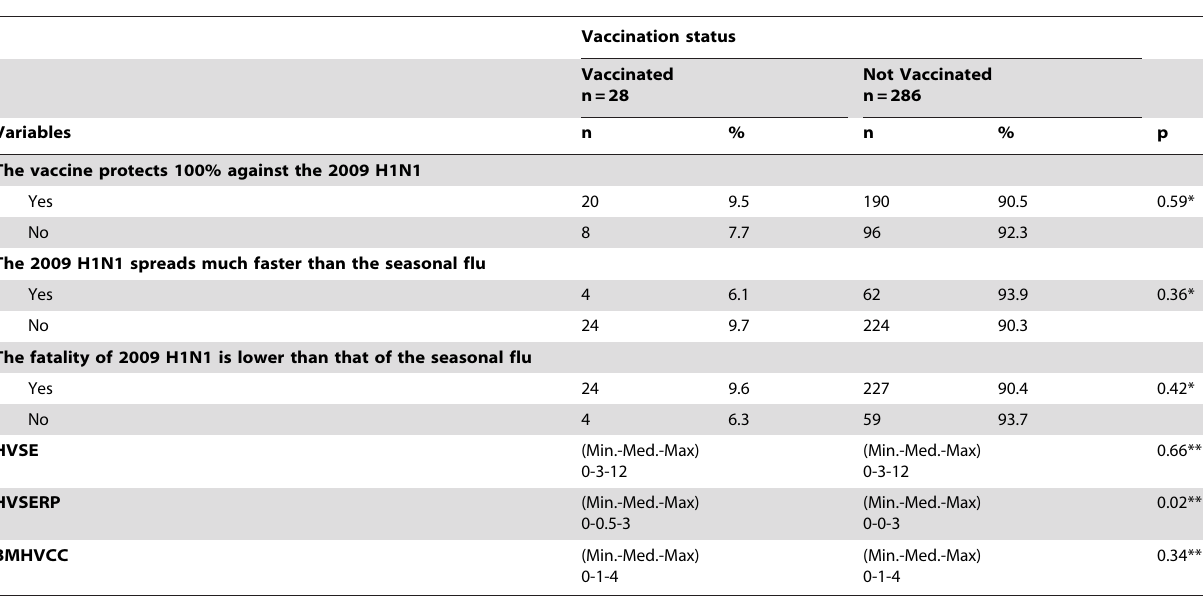
Table 2. The univariate analysis of factors affecting the vaccination status of pregnant women.